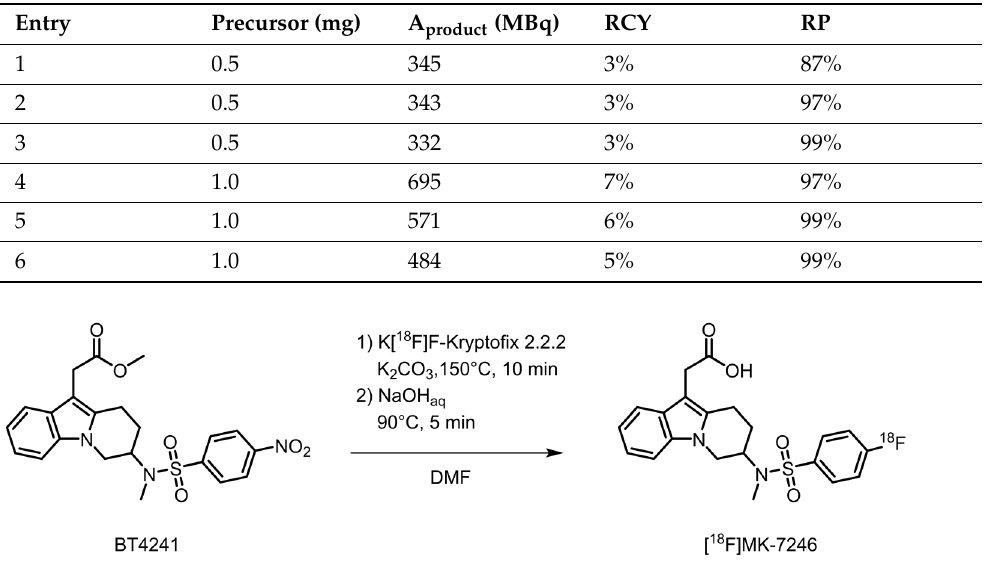
Table 1. Summary of [ 18 F]MK-7246 production.